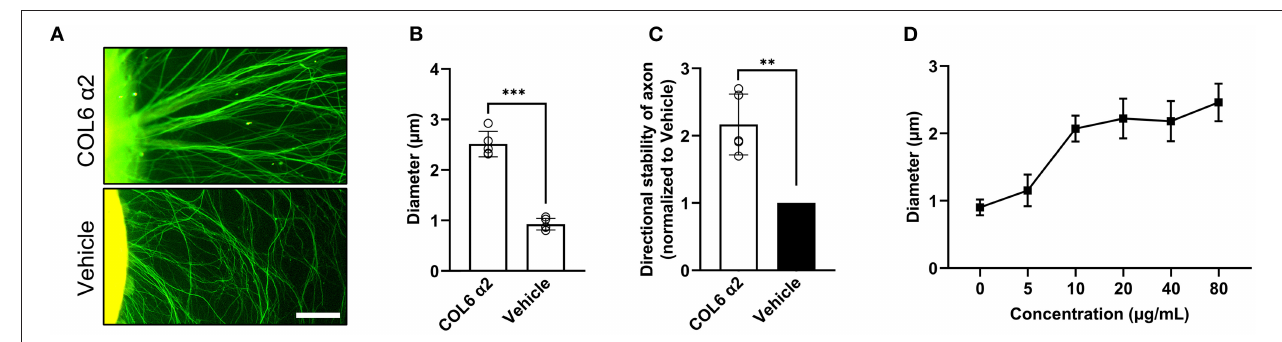
FIGURE 3 | COL6 α 2 treatment increases the diameter and directional stability of axon bundle in Matrigel. In the COL6 α 2 group, DRGs were seeded on a surface precoated with normal saline solution containing Matrigel (1 mg/ml) and COL6 α 2 (10 µ g/ml), and in the vehicle group, the surface for DRG seeding was precoated with normal saline solution containing only Matrigel (1 mg/ml). ( A ) Representative immunofluorescence images of DRG axons (labeled with NF200, green, stained with Alexa Fluor 488) in different groups. (B) Histogram of average diameter showing increased axon bundle diameter in the COL6 α 2, compared with that in the vehicle group ( n = 5 independent biological experiments, *** p < 0.0001, unpaired t- test). (C) Histogram showing more than twice the directional stability of axons in the COL6 α 2 group compared to the vehicle group ( n = 5 independent biological experiments, ** p = 0.0012, ratio paired t- test). ( D ) Different concentrations of COL6 α 2 were tested for coating in the COL6 α 2 group. The dose-dependent curve shows that the axon bundle diameter increased with increasing COL6 α 2 concentrations ( n = 5 independent biological experiments). Scale bar = 20 µ m in (A) .